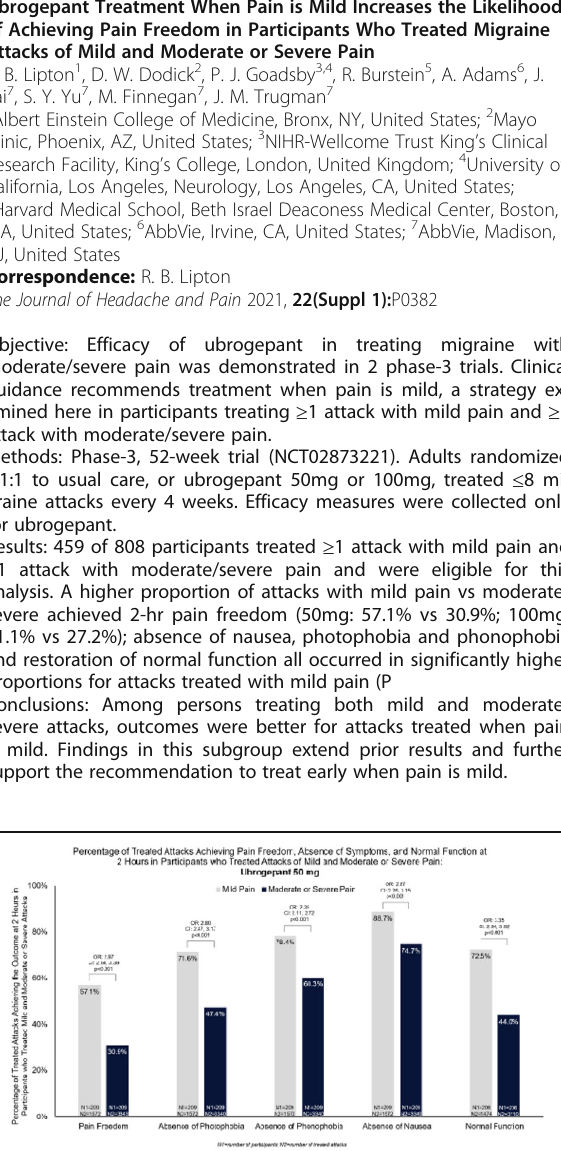
Fig. 1 (abstract P0382). See text for description